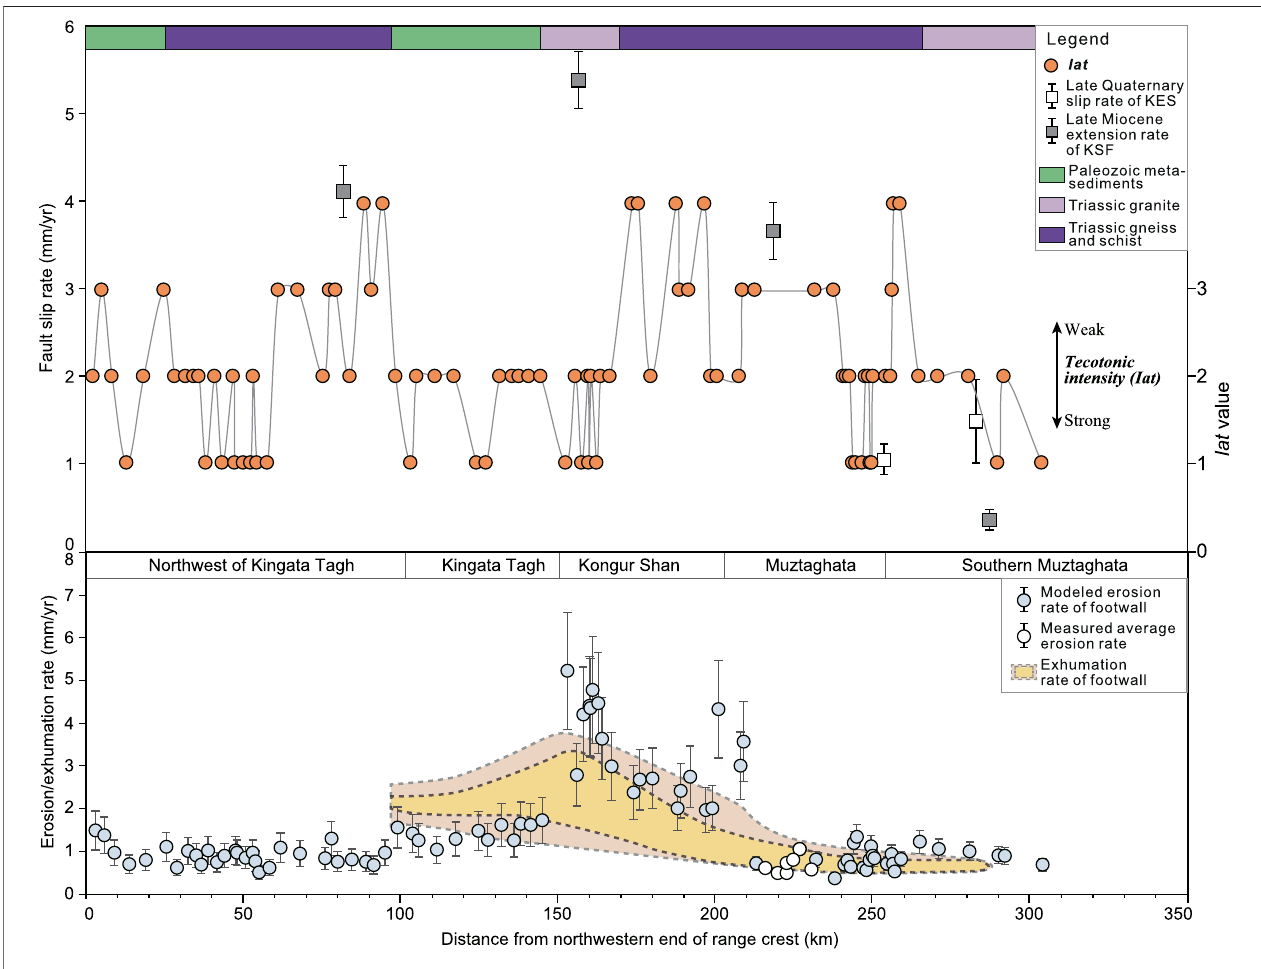
FIGURE 8 | Spatial correlation between average basin-wide erosion rates, footwall exhumation rates, extension rates along the KSF, as well as Iat values and lithologyonthewesternsideoftherange.Exhumationratesaremodi fi edfromThiedeetal.(2013)andshownasorangeshadedareasboundedbyblackdashedlinesfor 1 σ and 2 σ of modeled data. Late Miocene and Holocene extension rates along KSF are from Robinson et al. (2004), Robinson et al. (2007), Robinson et al. (2010) and Chevalier et al. (2015), respectively. Measured average basin-wide erosion rate are from Seong et al. (2009a). Note the starting point 0 km (NW end of divide line between E1 and W1) in Figure 1